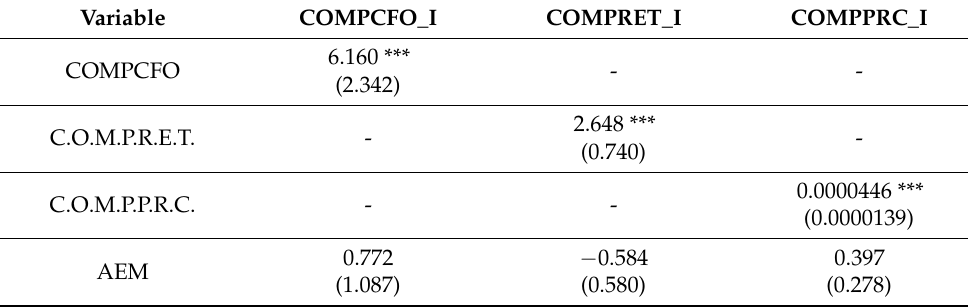
Table 7. Actual earnings management and accounting